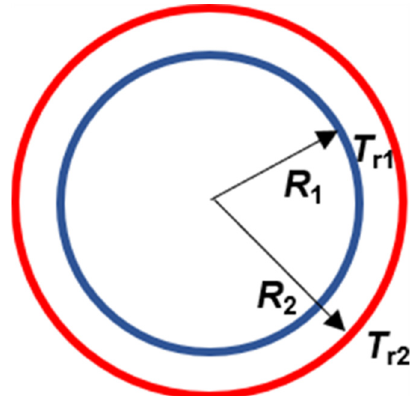
Figure 2. Diagram of the simplified model of the cylinder heat transfer model. It is considered that the heat conduction along the axial direction is negligible, and the temperature only changes along the radial direction. In addition, the temperature